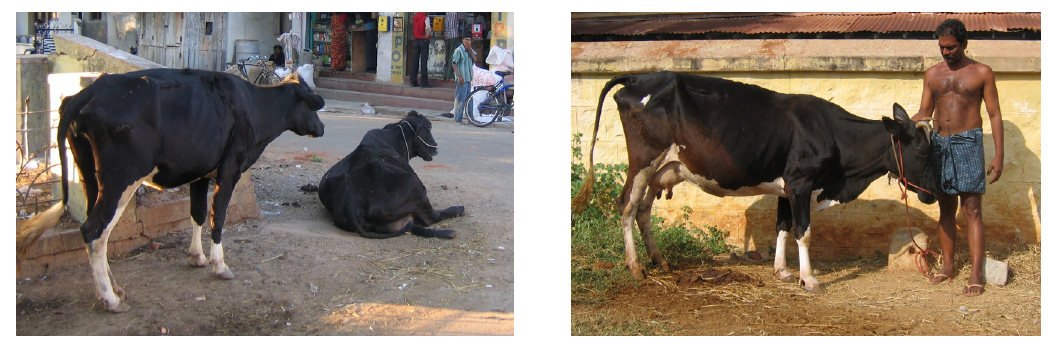
Figure 25. Exotic crossbreds and Friesian cow in India, 2005 (photographs by Anno